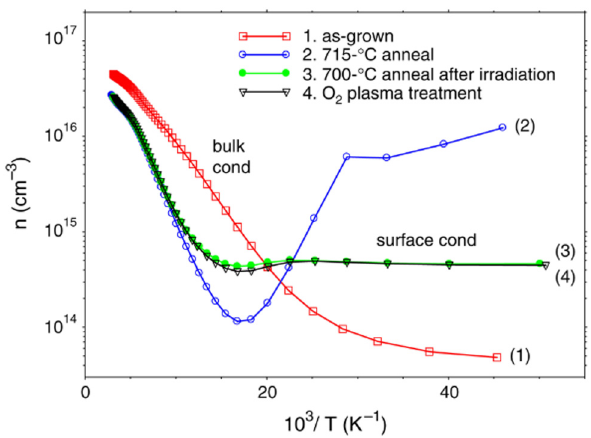
Figure 17: Carrier concentration versus temperature for sample #2: ( 1 ) as - grown, ( 2 ) annealed at 715°C, ( 3 ) annealed at 700°C after irradiation, and ( 4 ) subjected to a remote O 2 plasma. Reproduced with permission from Elsevier [ 311 ]